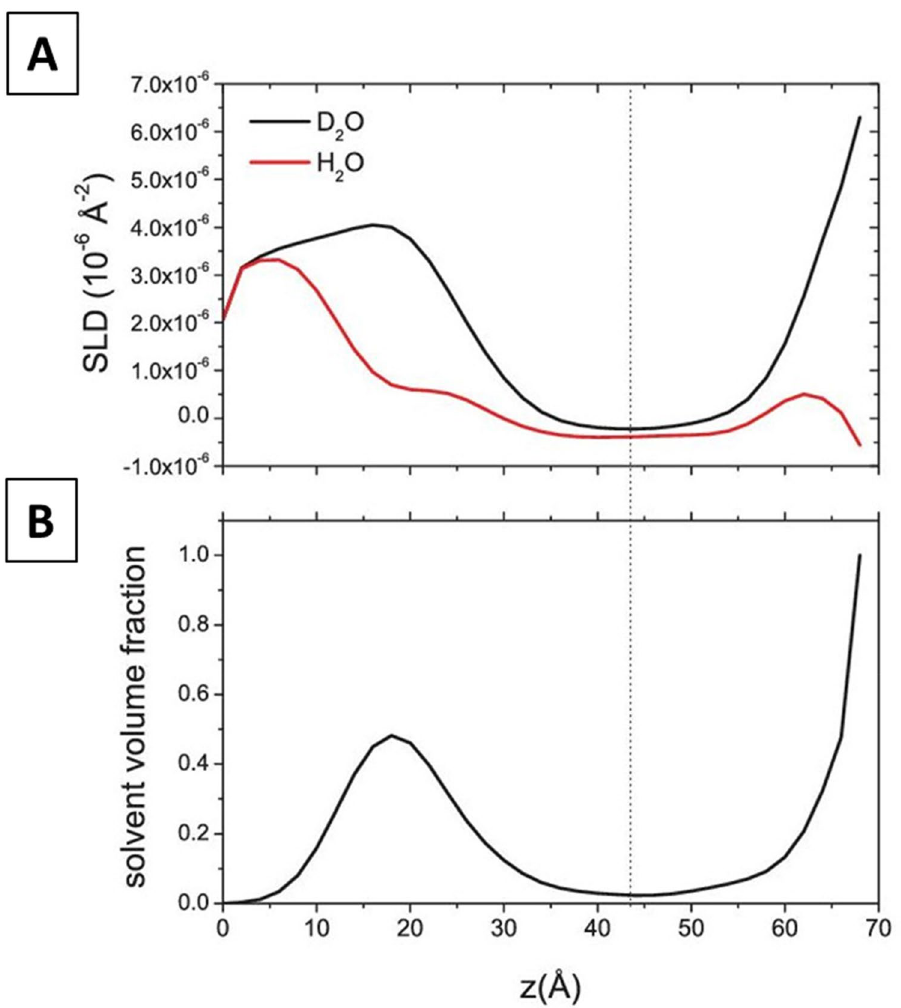
Figure 6. ( A ) SLD profiles and ( B ) solvent volume fraction for PLPC/sitosterol (80/20) membrane obtained with the model-free approach. Dotted line represents the center between upper and lower leaflet headgroup